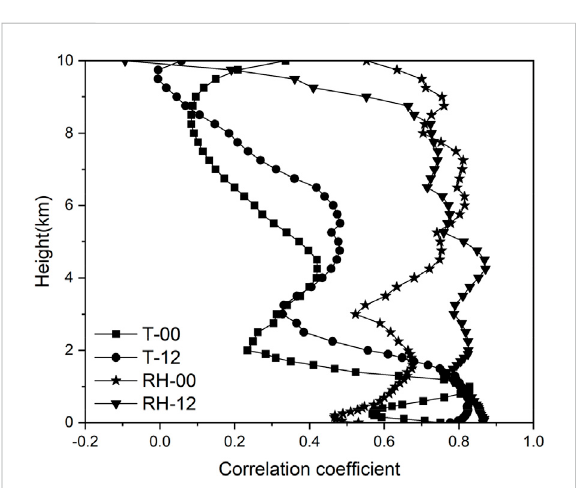
FIGURE 1 The correlation coef fi cient of temperature and humidity data between microwave radiometer and sounding.